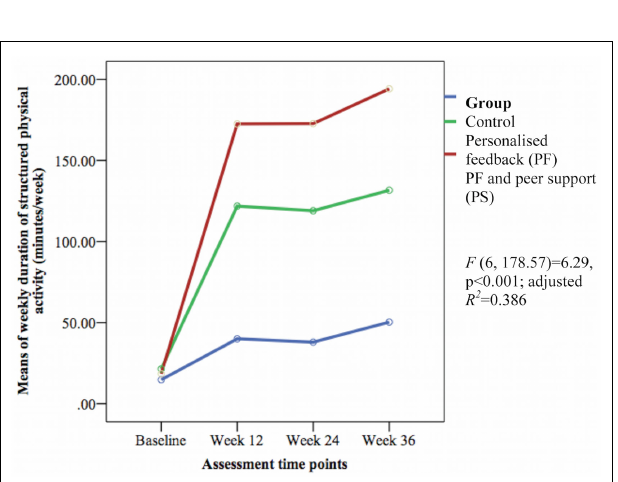
FIGURE 4 | Means differences on weekly frequency of structured physical activity between groups over time .